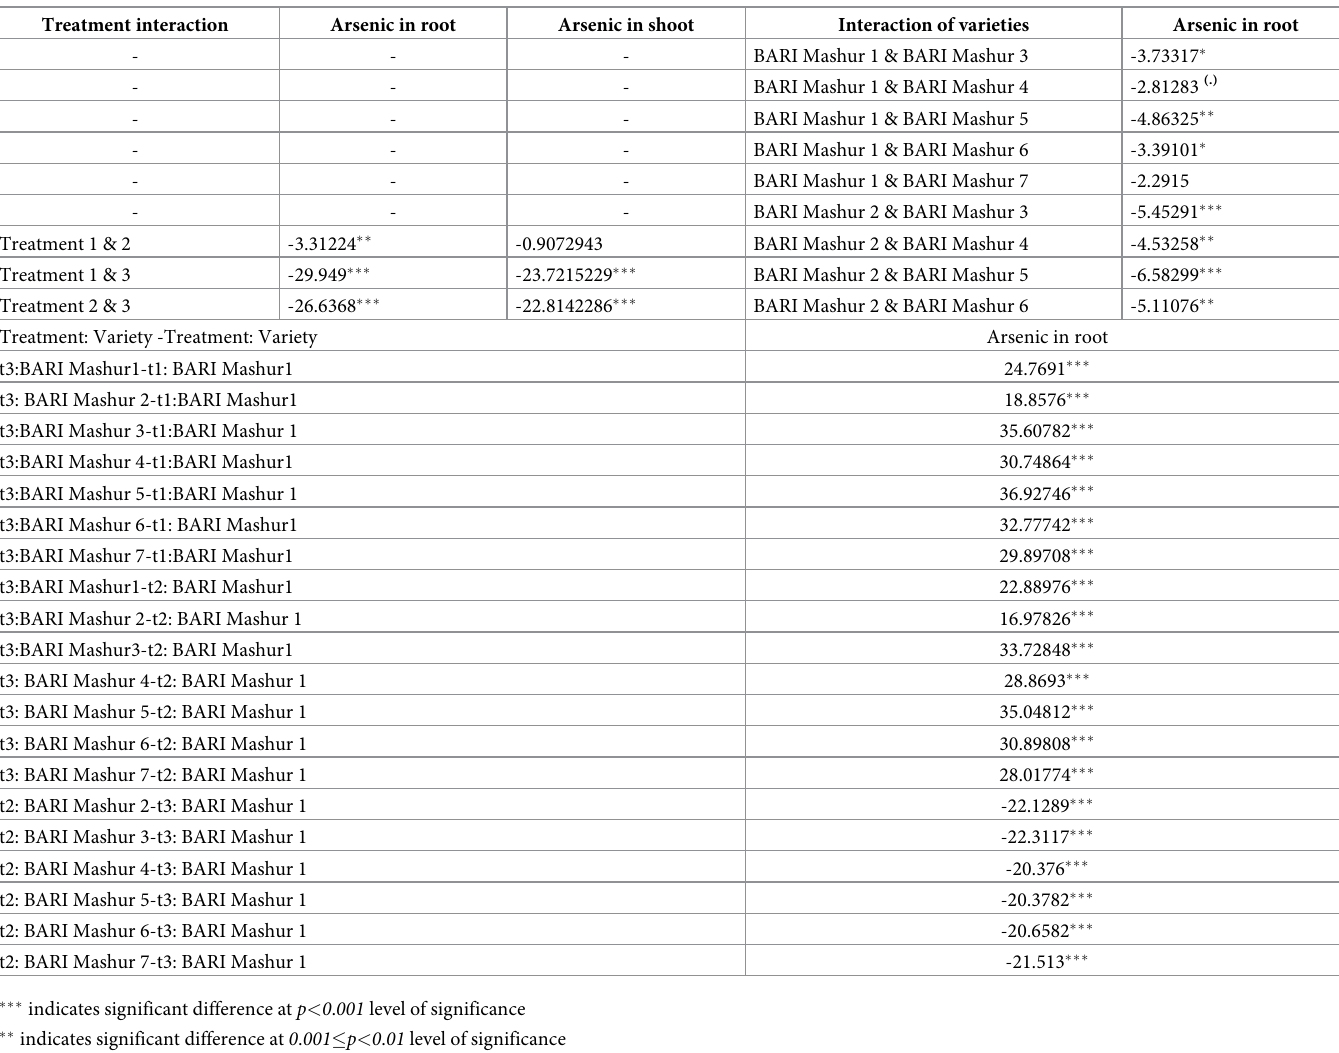
Table 3. Arsenic uptake in root and shoot of lentil